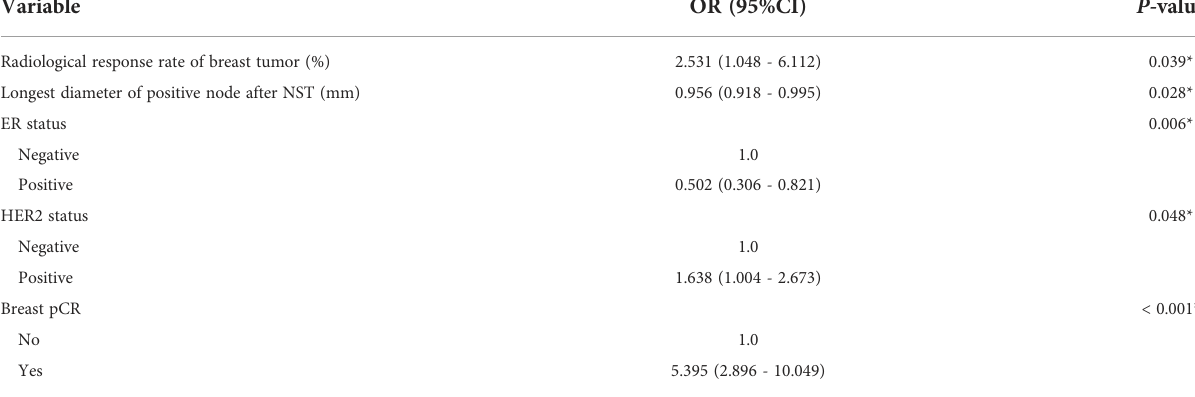
TABLE 2 Multivariate logistic regression analysis of variables associated with axillary pCR in the training set (N=378). Variable